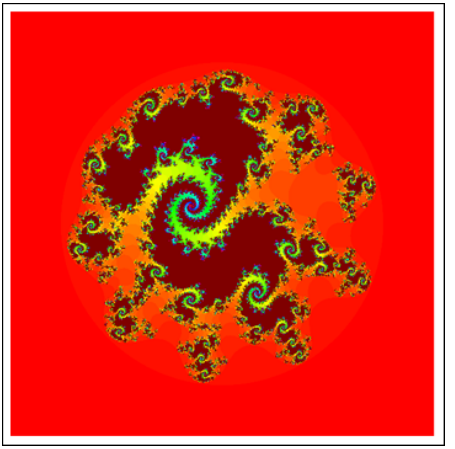
Figure 10. Decade Julia set for the function h ( z ) = z 10 + c via F-iteration.